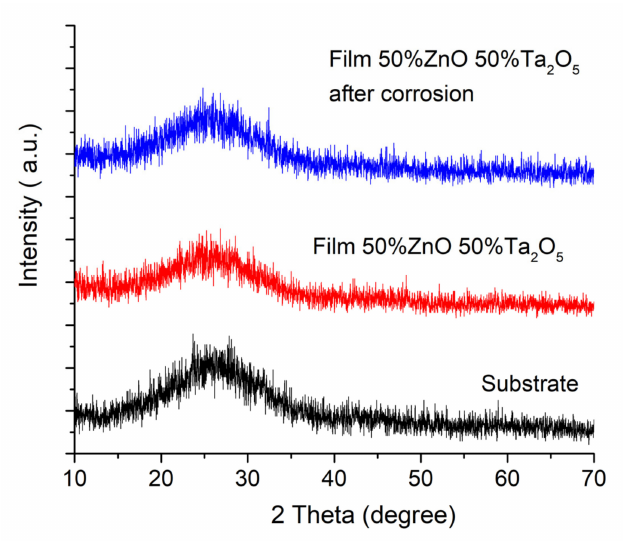
Figure 1. XRD patterns of the substrate 50%ZnO50%Ta 2 O 5 film before and after corrosion. Figure 2 shows the SEM image and EDS spectrum of the 50%ZnO50%Ta 2 O 5 film deposited on a borosilicate glass support using e-gun